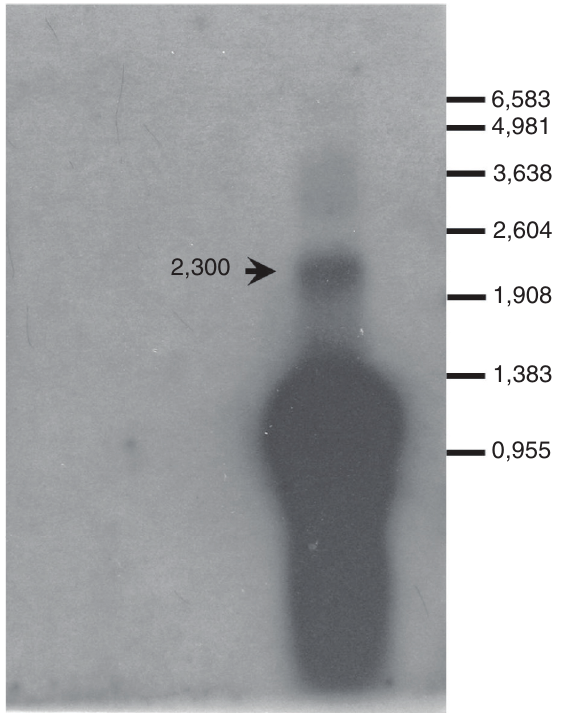
/ aacA4 gene GES-1